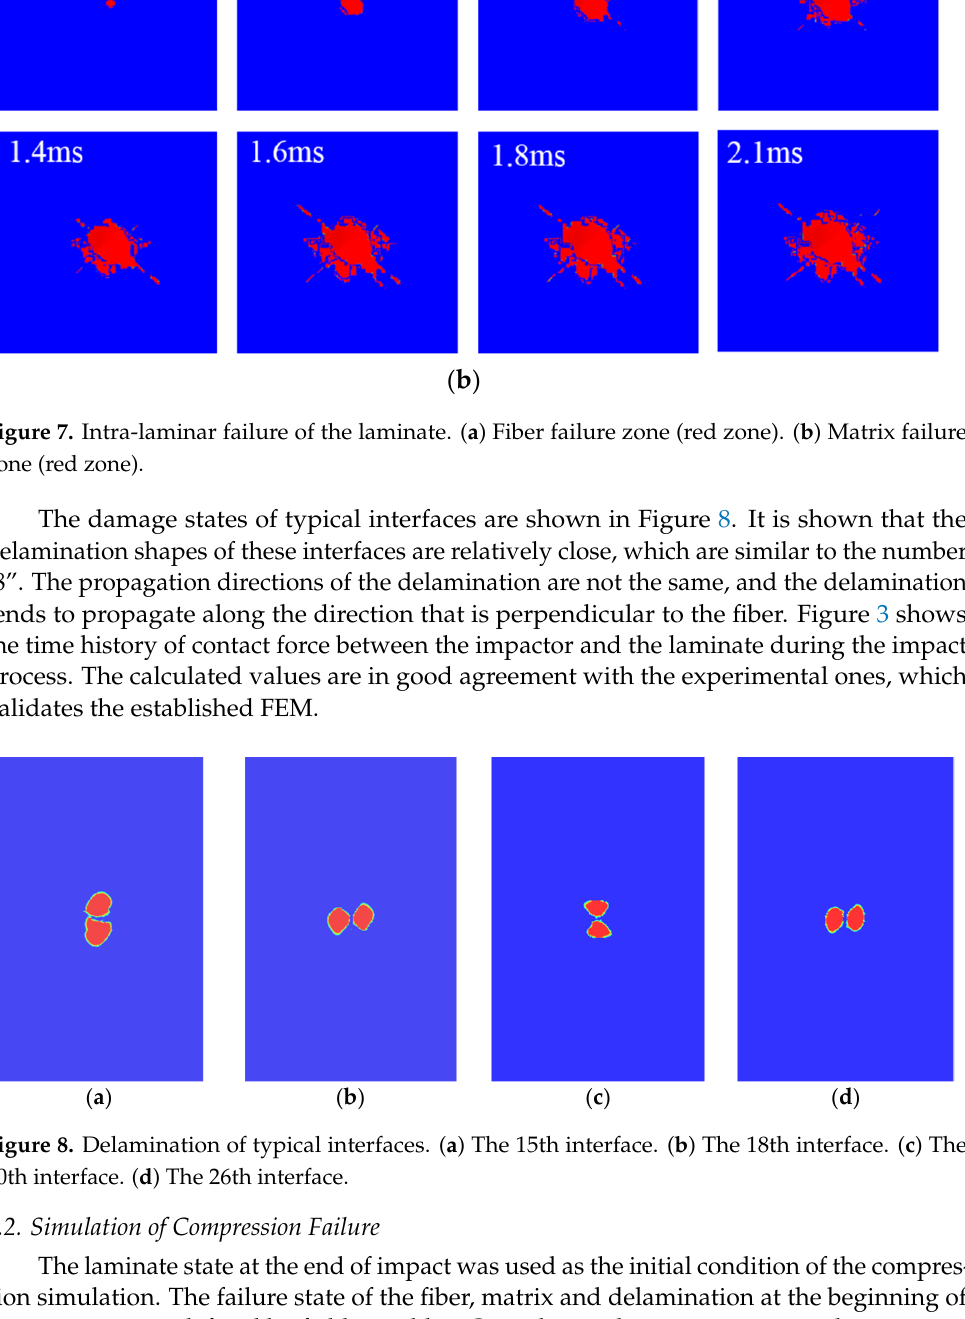
Figure 8. Delamination of typical interfaces. ( a ) The 15th interface. ( b ) The 18th interface. ( c ) The 20th interface. ( d ) The 26th interface.